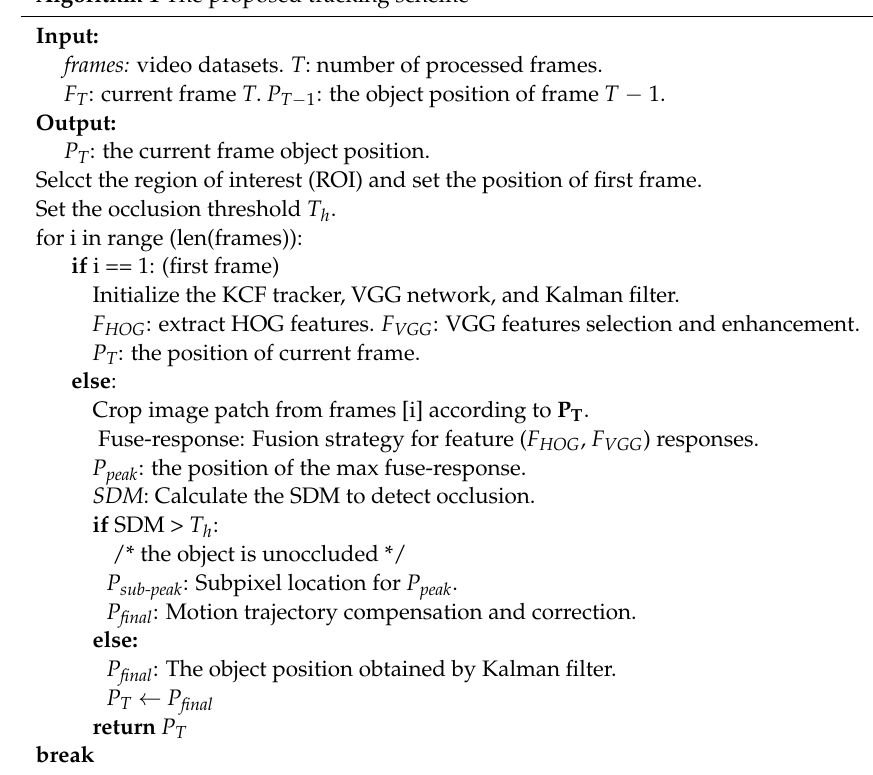
Algorithm 1 The proposed tracking